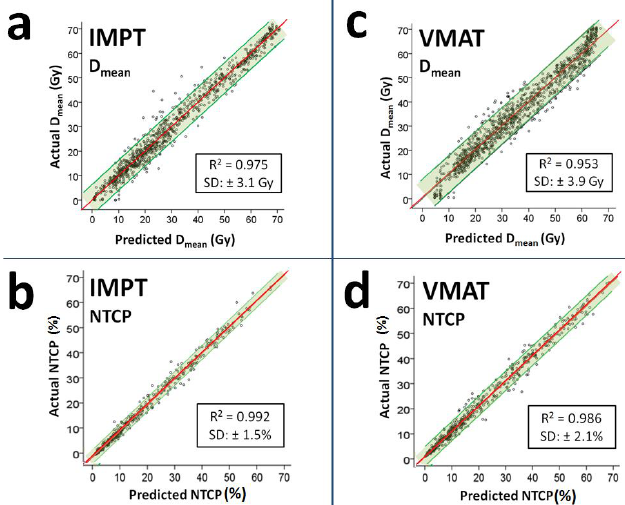
Figure 4. Predicted vs. actual values for eight OAR D mean for IMPT ( a ) and VMAT ( c ); and predicted vs. actual four NTCP values for IMPT ( b ) and VMAT ( d ) shown in the same scatter plot. The red lines are the origins where predicted and actual values are equal to each other. The green areas indicate the 95% CIs for the individual predictions.